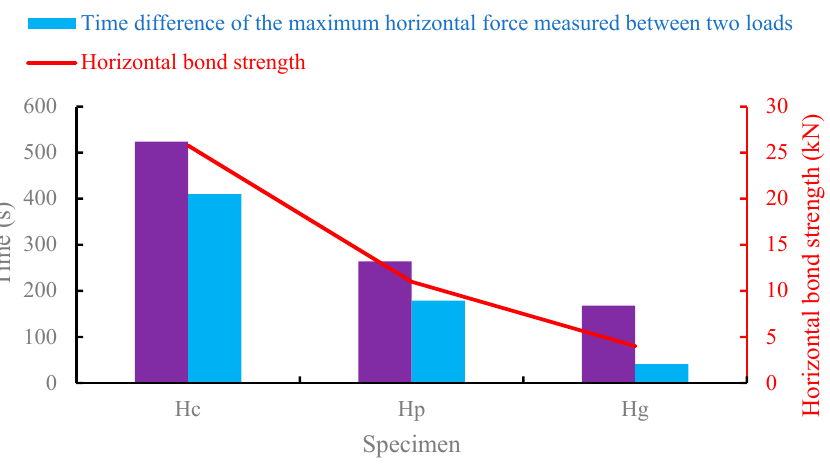
Figure 20. Comparison of the horizontal bonding strength of different specimens and the time when the maximum horizontal force was measured. Table 8. The horizontal bonding strength of different specimens and the time when the maximum horizontal force was measured. Horizontal cohesive force (kN) Time of maximum horizontal bearing capacity measured at the first loading (s) Time of maximum horizontal bearing capacity measured by the second loading (s) The time difference of the maximum horizontal bearing capacity measured by two loadings